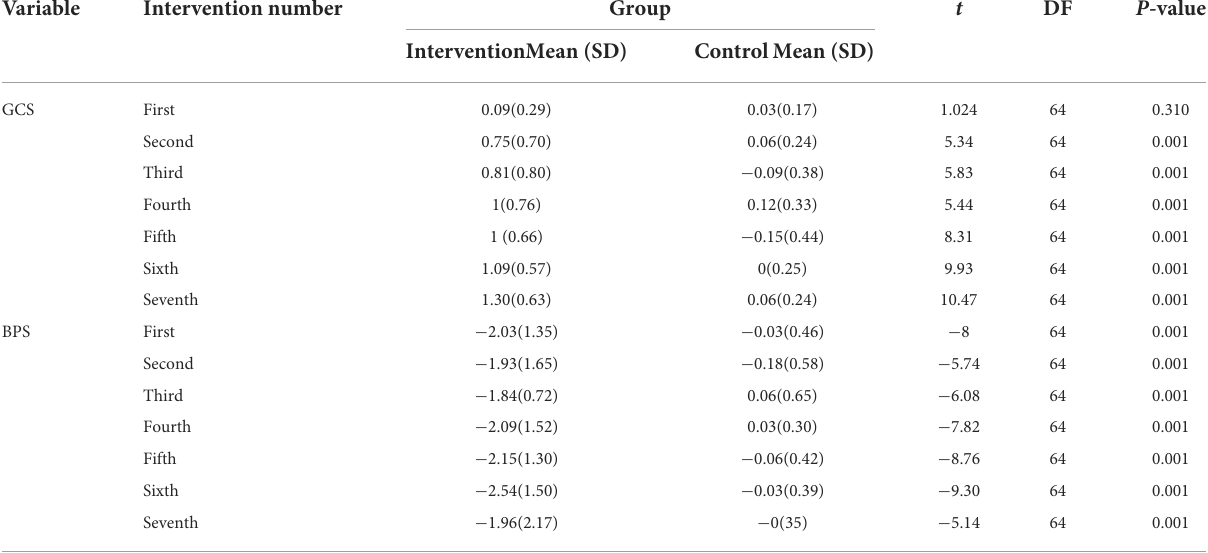
TABLE 2 Comparison of study groups in terms of mean difference of GCS and BPS scores before and after each intervention ( N = 66). Variable Intervention